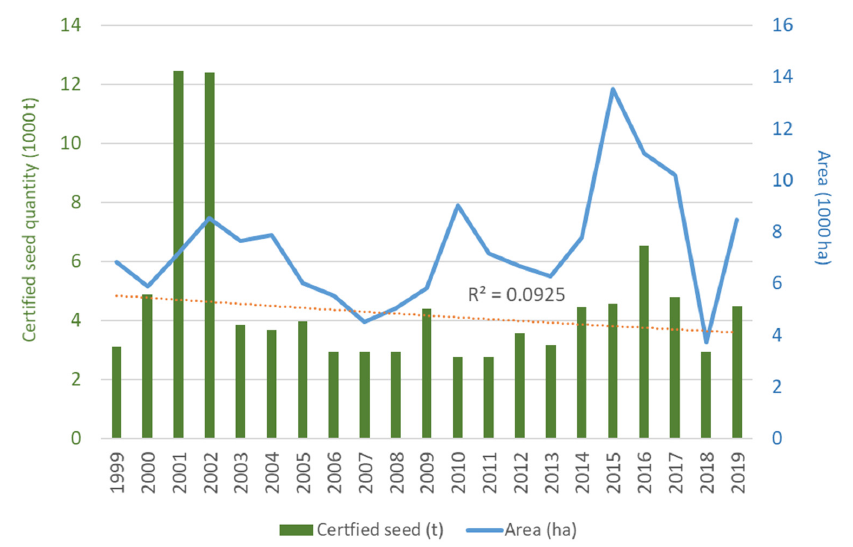
Figure 16. Area of lupins seed production and amount of certified seed between 1999–2019 in the EU member states [65].